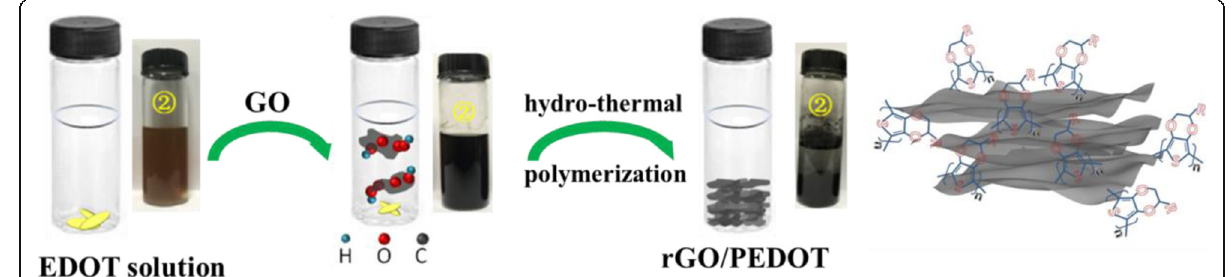
Fig. 1 The schematic diagram of hydrothermal polymerization of rGO/PEDOT